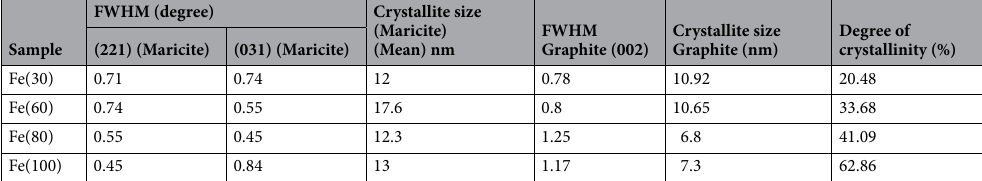
Table 1. Crystallite sizes and DOC of NaFePO 4 -C composite samples.